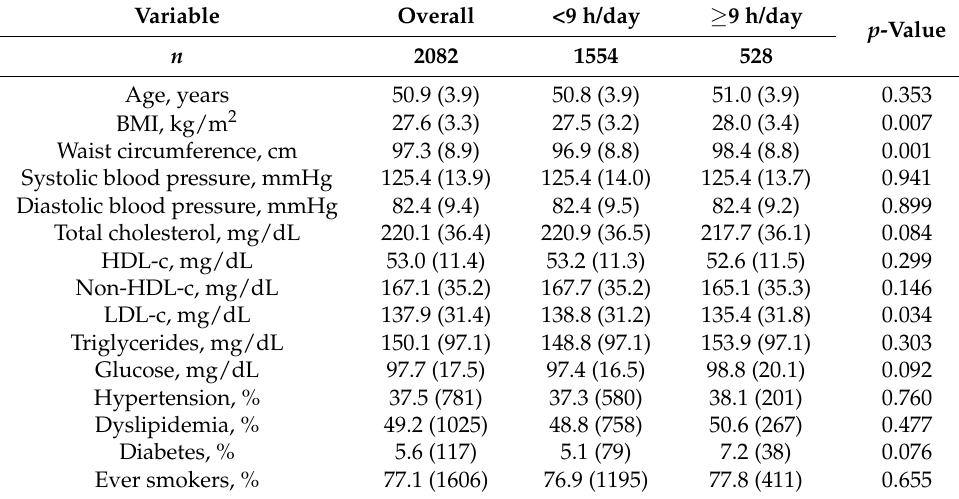
Table 1. Baseline characteristics of study participants according to sitting time category.